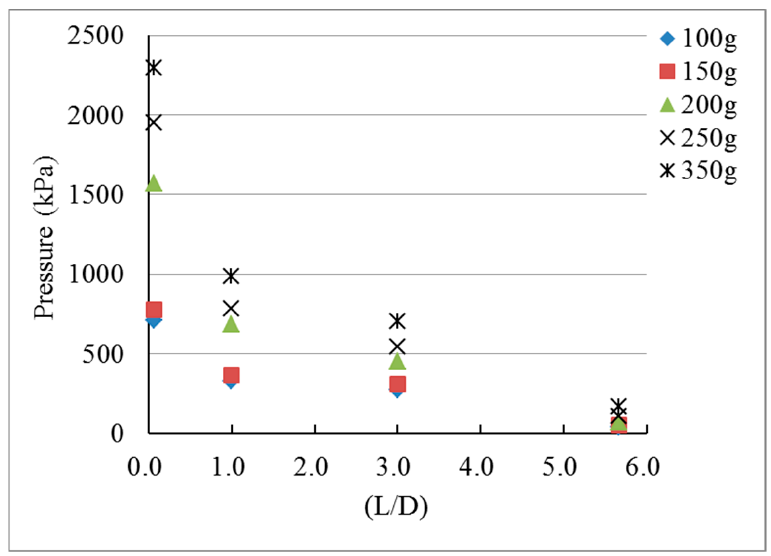
Figure 9. Comparison diagram of double-pressure relief orifice plate explosion experiment results.